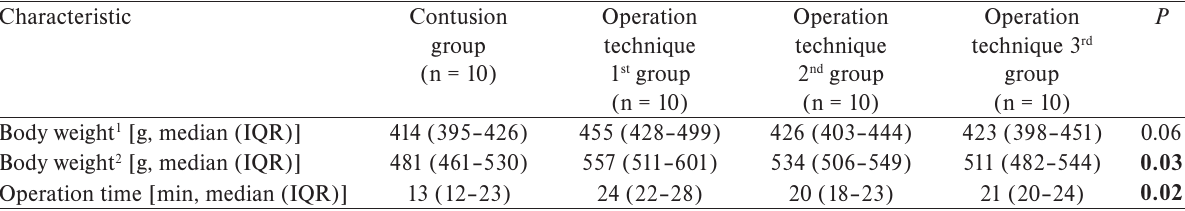
Table 1. Clinical characteristic of the rat